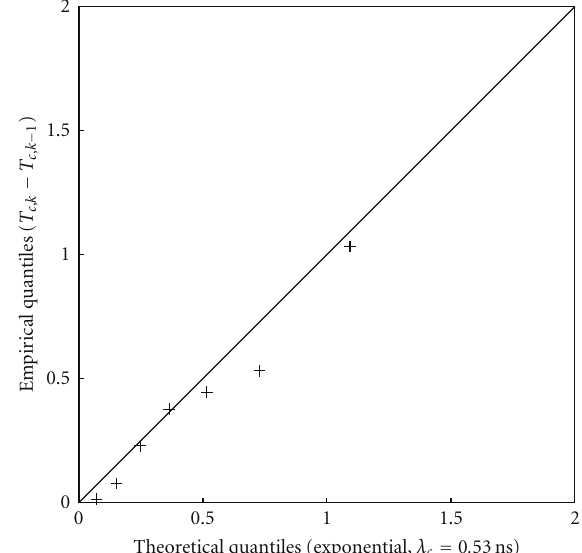
Figure 5: CDF plot of Φ A c and estimated theoretical CDFs for a , k cluster at measurement location 5. Figure 6: QQ plot of quantiles of T c , k − T c , k − 1 versus quantiles of an exponential distribution for a cluster at measurement location